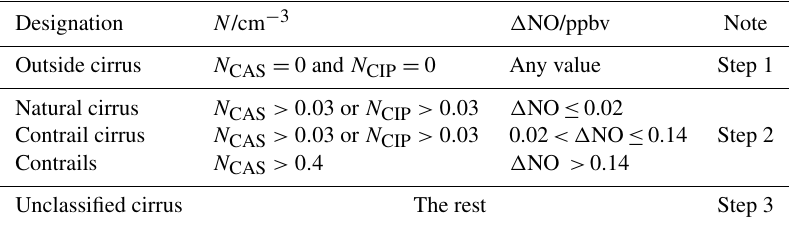
Table 1. Cirrus classification according to microphysical properties ( N ), and tracer measurements (NO) measured by instruments aboard